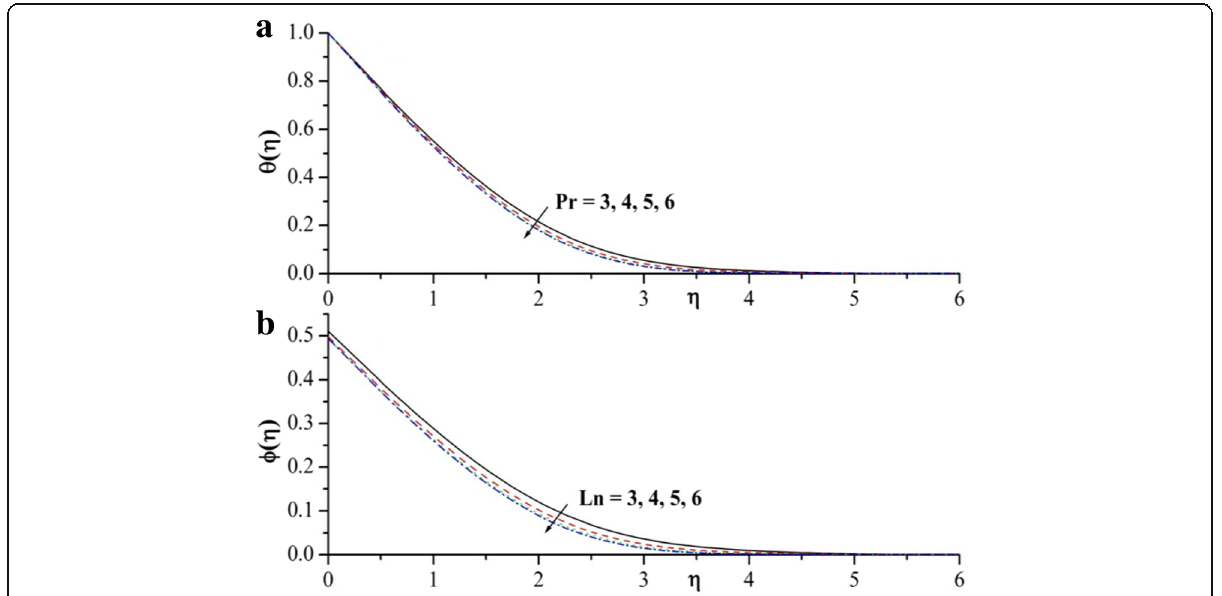
Fig. 15 a Temperature and b nanoparticle concentration profiles for variable values of Pr and Ln,